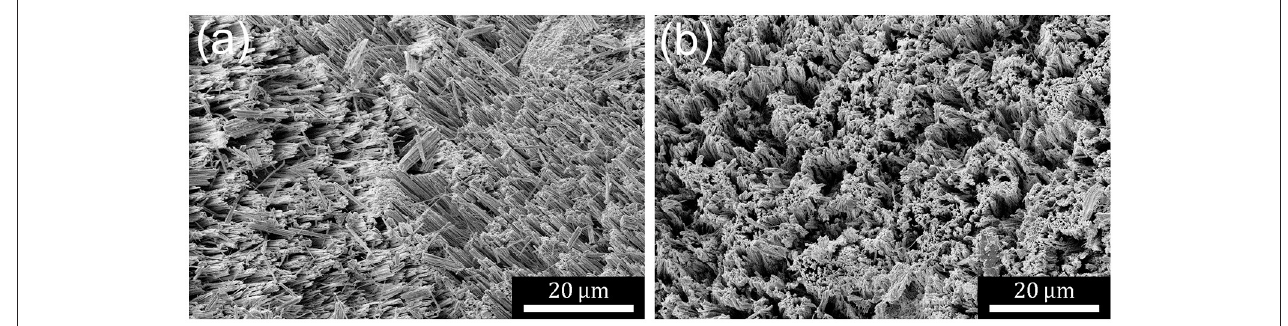
FIGURE 1 | (a) SE SEM micrograph showing a typical metallurgical grade powder particle after MACE. Etch track pores form structures in domains with different axial directions. Particles are porosified to expose several different morphologies. (b) SE SEM micrograph showing a typical single-crystal electronics grade powder particle after MACE. Domain sizes are much greater and the angle of the etching axis deviates less from the local normal than observed for metallurgical grade Si.